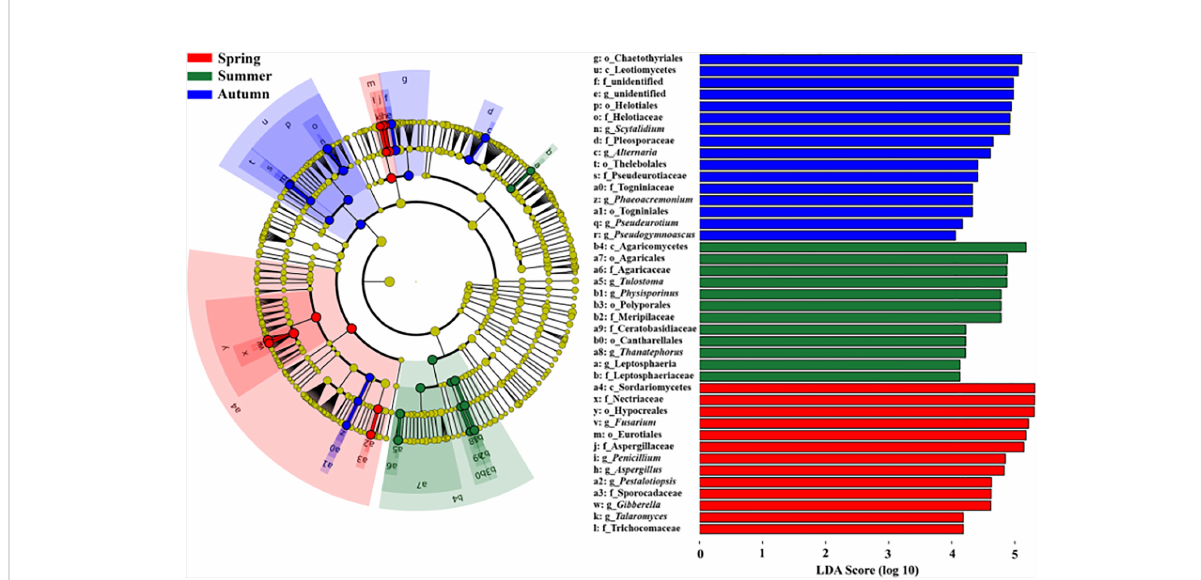
FIGURE 5 LDA effect size taxonomic cladograms and score histograms showing fungal indicator taxa of each season. The nodes from inside to outside indicate the taxonomic levels with Kingdom, Phylum (p_), Class (c_), Order (o_), Family (f_) and Genus (g_). The small yellow circles represent the fungal taxa with no signi fi cant differences, while small circles and sectors with other different colors represent the signi fi cantly enriched fungal taxa with a LDA value larger than 4.0 in different groups. The size of each small circle is roughly proportional to the relative abundance of that given